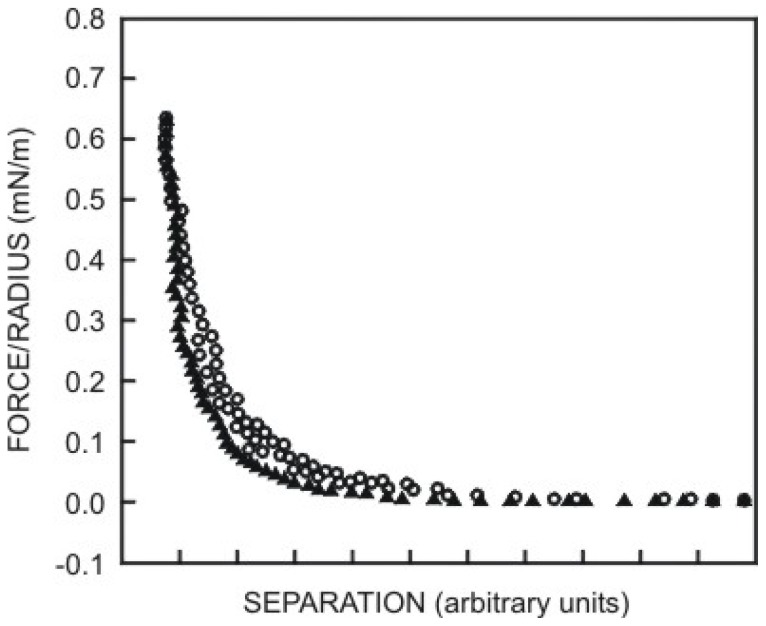
Forces measured between an α-alumina sphere (O) or silica sphere (Δ) and a flat Teflon AFTM surface in cyclohexane. The separation distance is in arbitrary units and the distance between the tick marks is 2 nm (Reproduced by permission of Elsevier [307]).